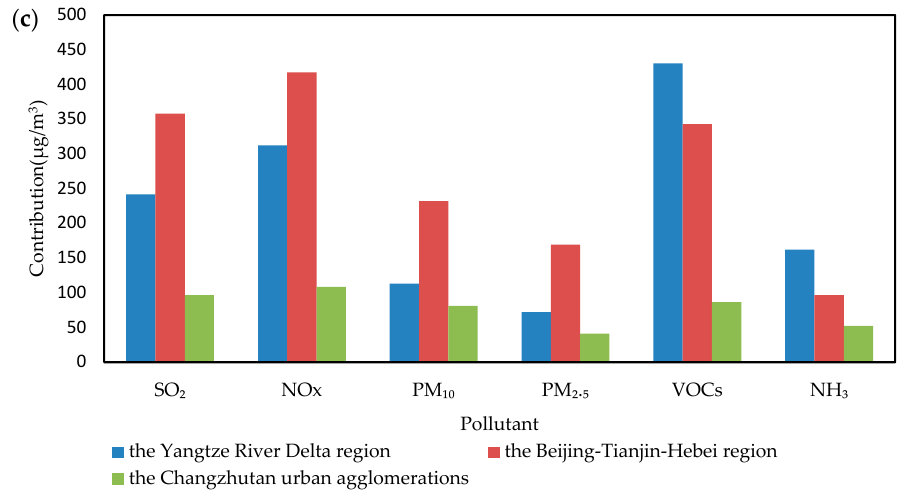
Figure 12. Comparison of air pollutant emission inventory established by different studies [27,38]. ( a ) Emissions of atmospheric pollutants per unit area (kg/m 2 ). ( b ) Emissions of atmospheric pollutants per capita emissions (kg/person). ( c ) Emissions of atmospheric pollutants per unit GDP (kg/billion).